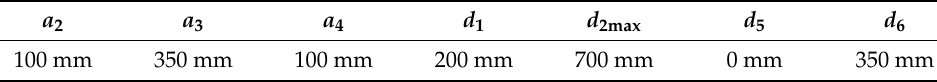
Table 1. The dimension parameters of the manipulator